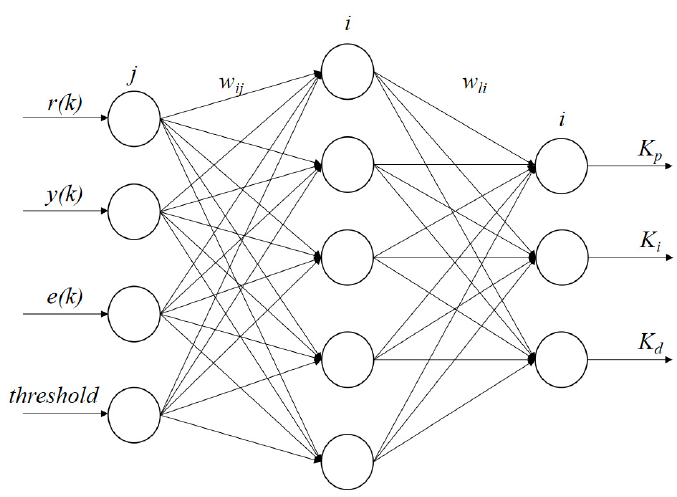
Figure 4. BP neural network structure.